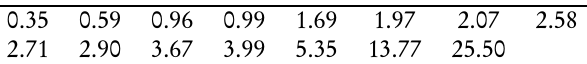
Data set in Example